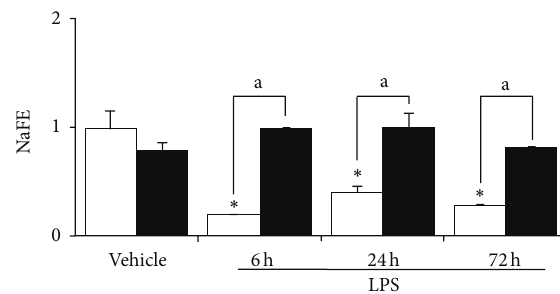
Figure 4: Fractional excretion of sodium (NaFE) in diabetic (black bars) and nondiabetic (open bars) LPS-injected mice. Values are mean ± SEM. ∗ 𝑃 < 0.05 versus control value and a 𝑃 < 0.01 versus